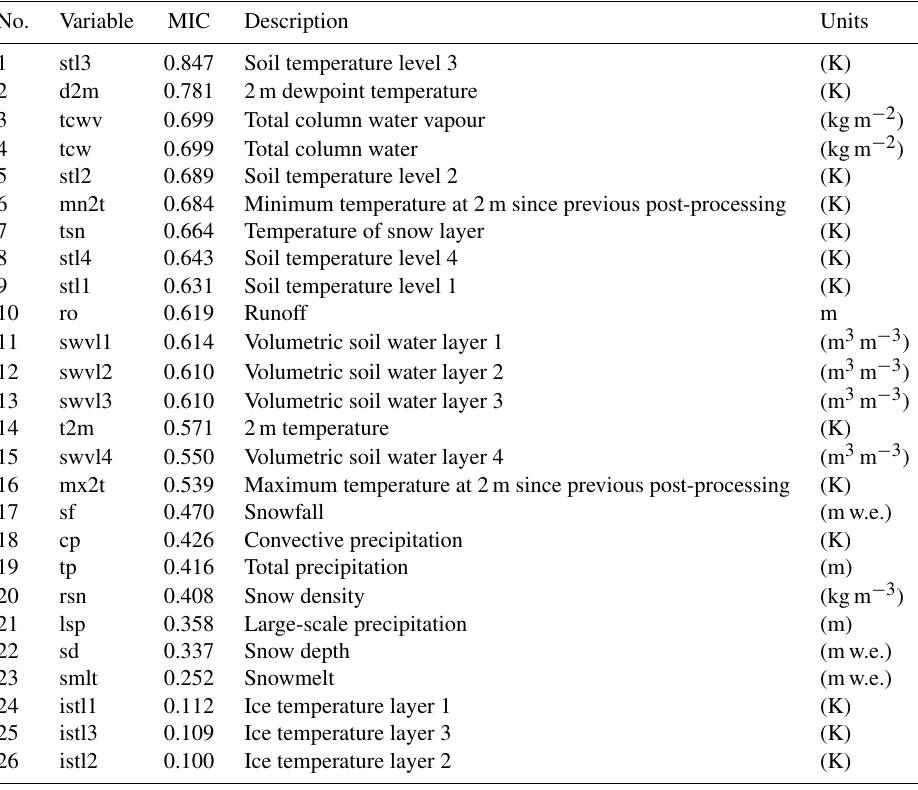
Table A1. Description and notations of the ECMWF reanalysis fields.